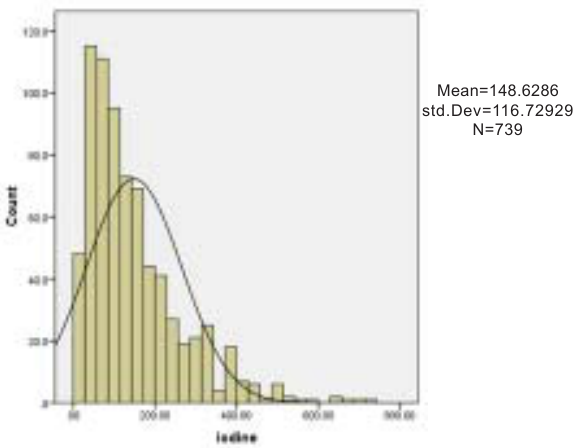
Figure 1. Distribution pattern of urinary iodine values in pregnant